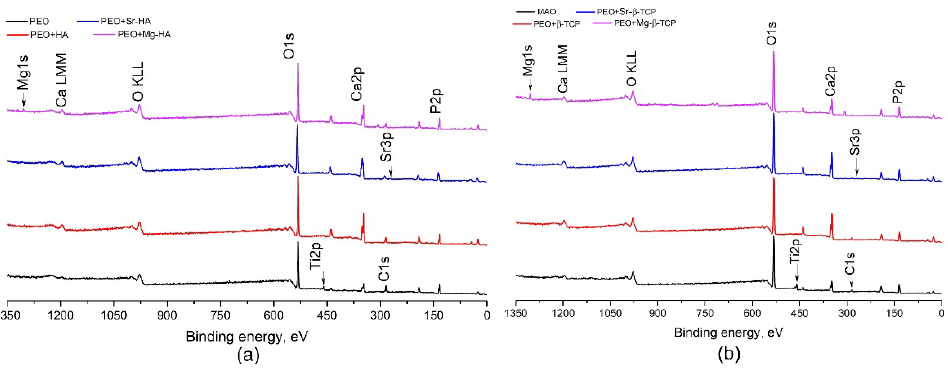
Figure 4. The XPS survey spectra for the CaP PEO (black line on Figure 4a,b) and composite HA ( a ) and β -TCP ( b ) RFMS coatings.